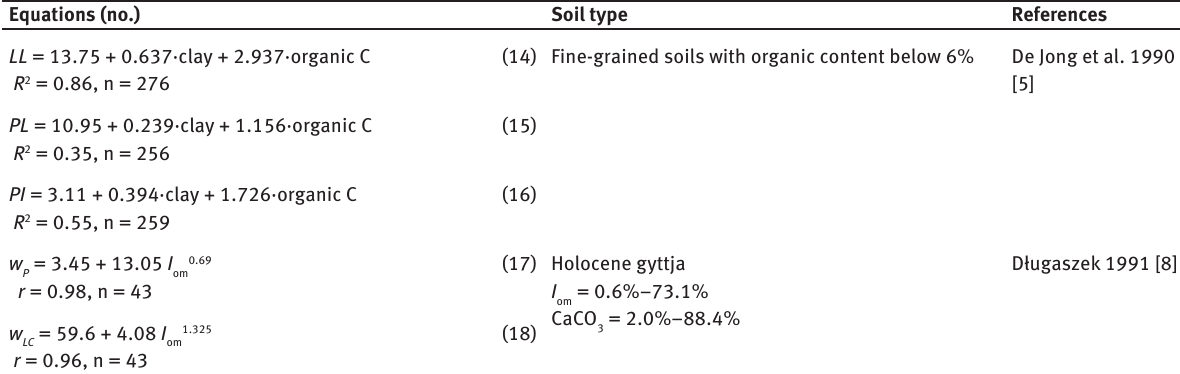
Table 2: Relationships between the Atterberg limits and the clay and organic matter contents in the literature. Equations